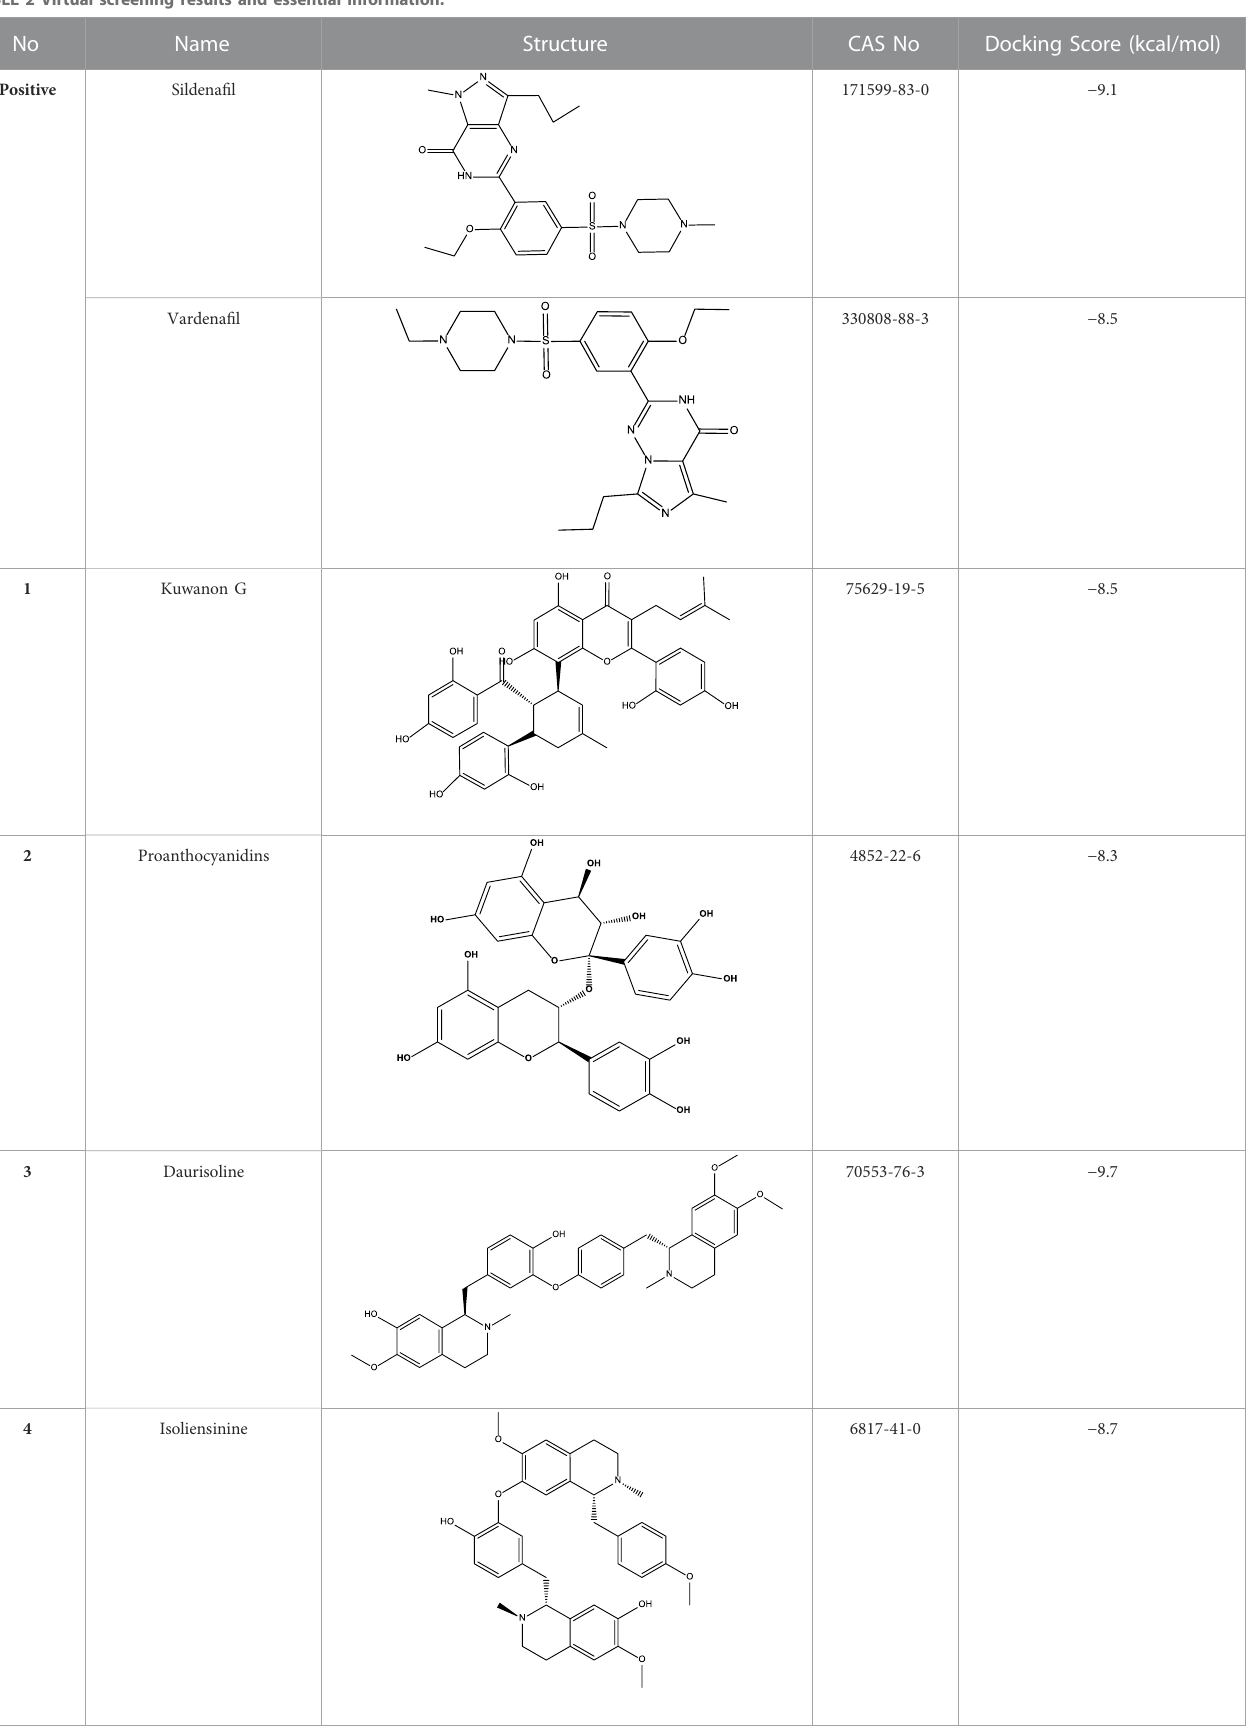
TABLE 2 Virtual screening results and essential